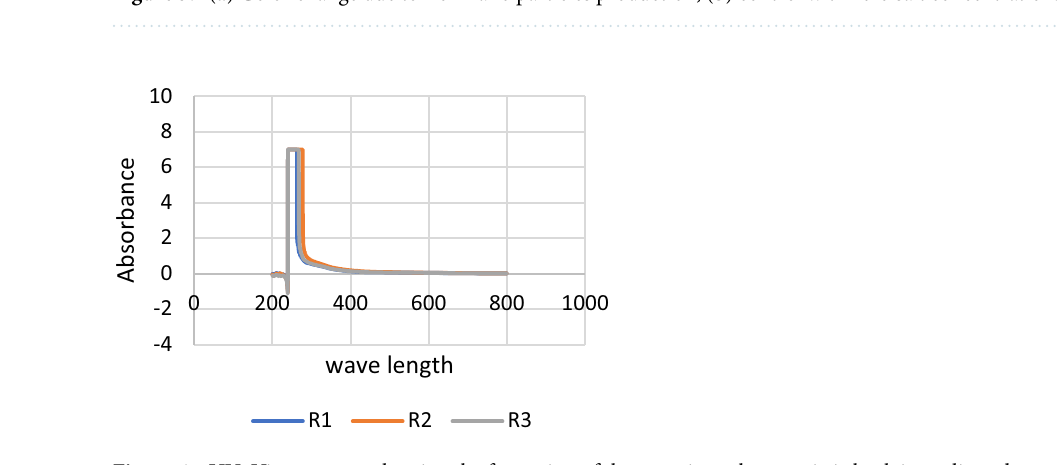
Figure 3. ( a ) Color change due to iron nano particles production, ( b ) control with zero salt concentration.